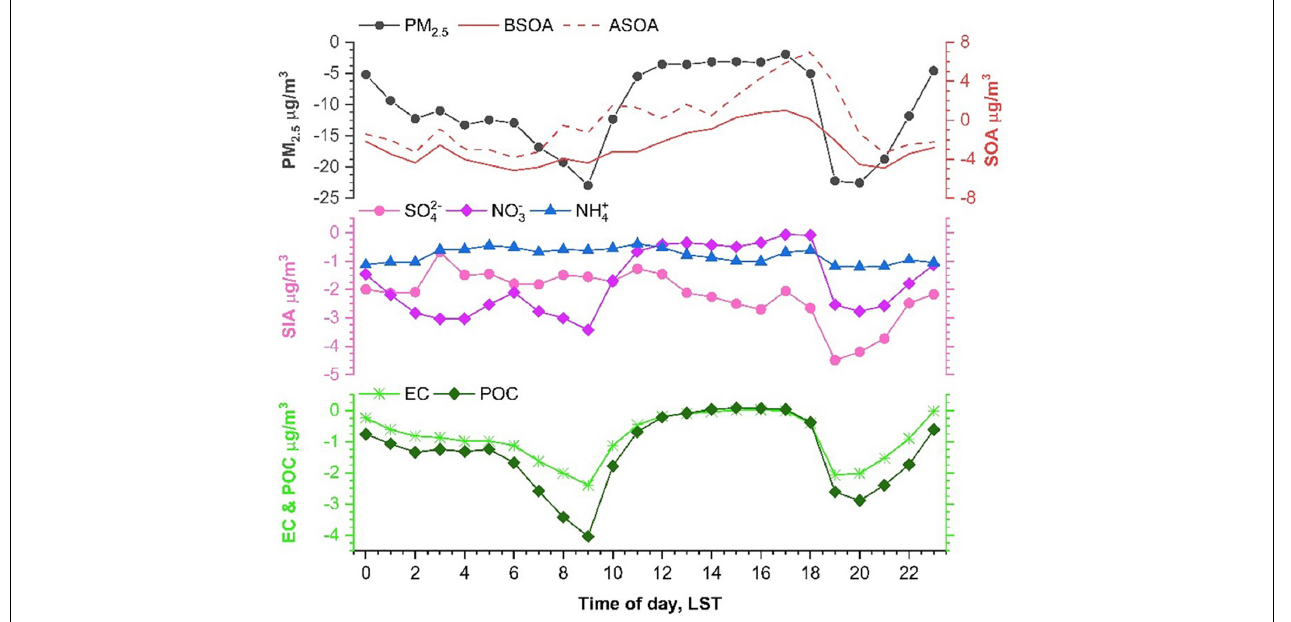
FIGURE 8 | Diurnal pattern of PM 2 . 5 and chemical components over UEA of Chengdu between 2000 and 2017. The average data was calculated from the value of UEA.